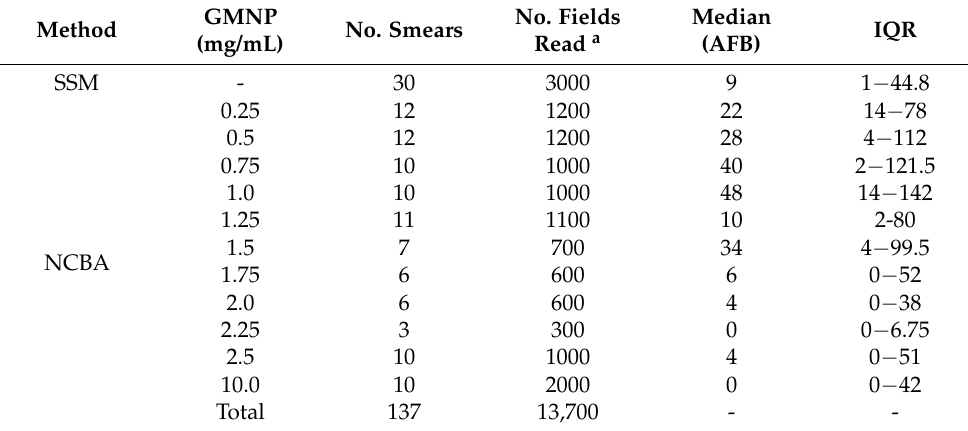
Table 2. Descriptive values and mean differences of the number of AFB after performing the NCBA and SSM technique in aliquots of sputum samples from people with pulmonary tuberculosis. GMNP No. Method No. Smears (mg/mL)